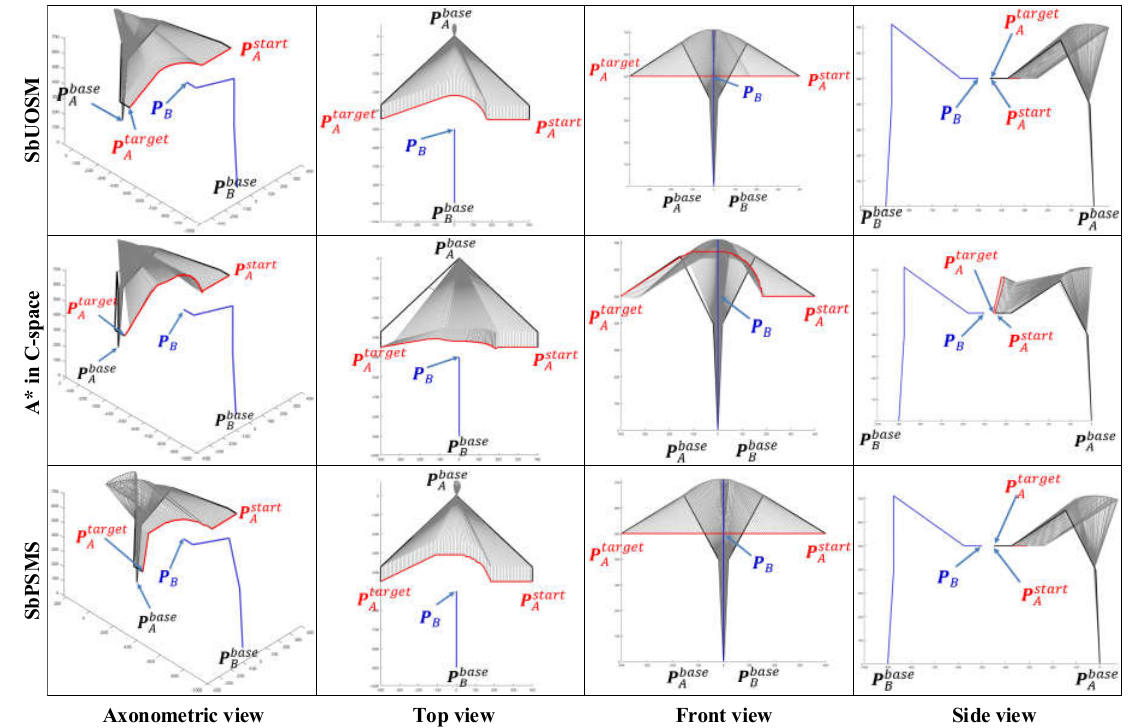
Figure 10. Comparison of simulation results of three path-planning algorithms for Case 1.